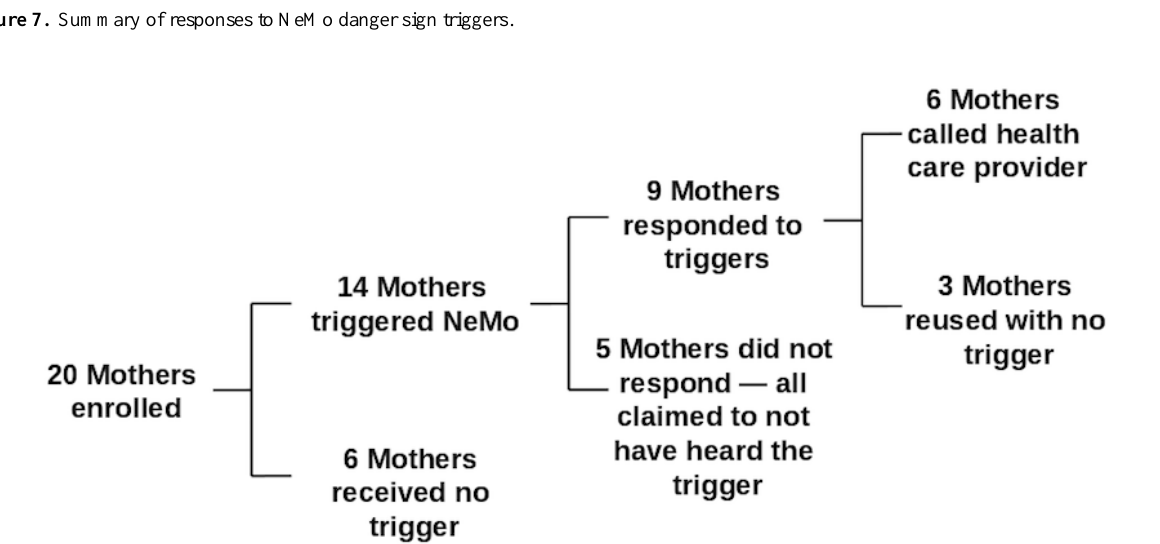
Figure 7. Summary of responses to NeMo danger sign triggers.